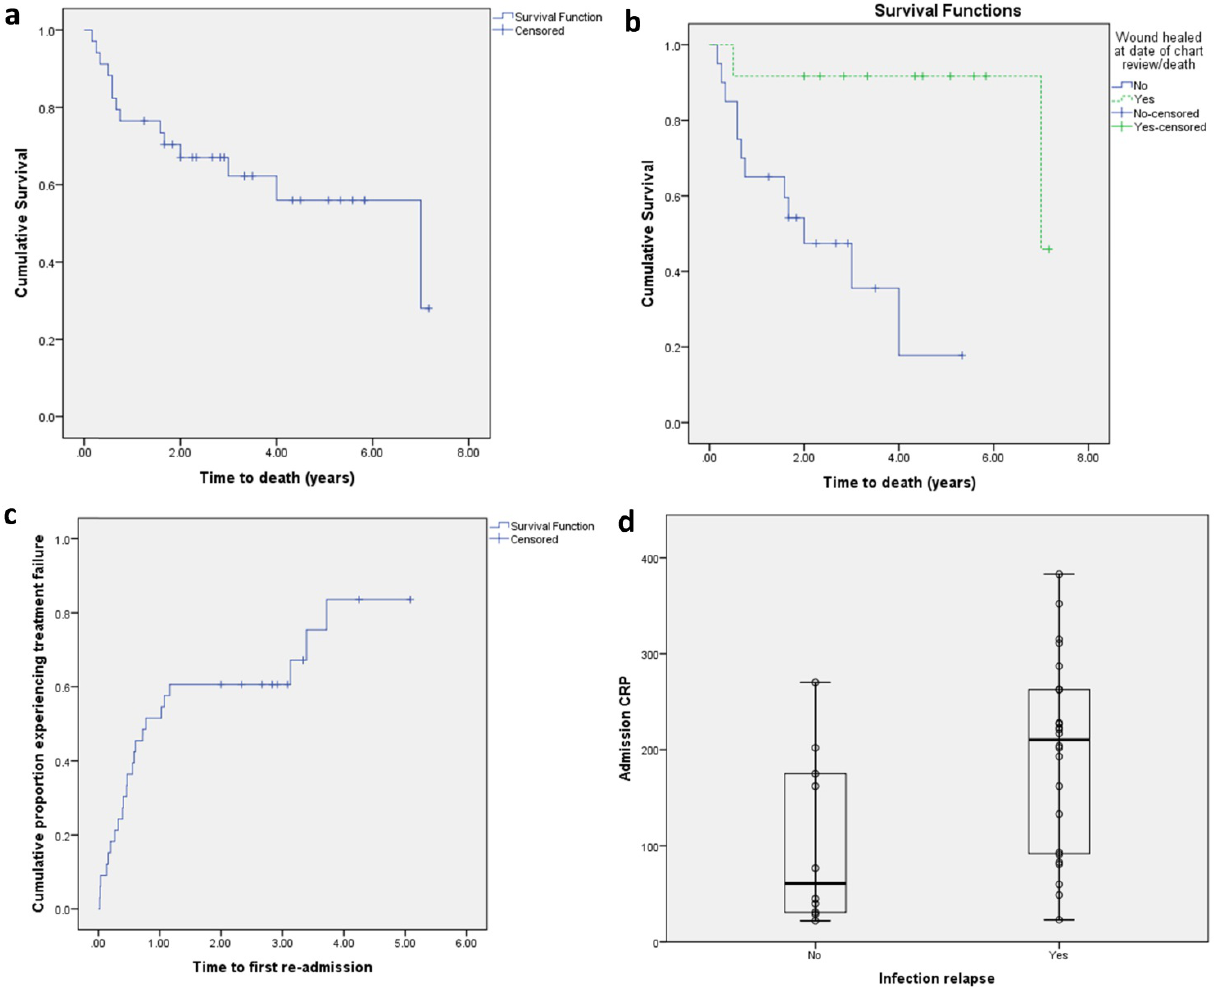
Figure 2. Clinical outcomes. a) Kaplan-Meier analysis of patient survival. b) Log rank analysis of patient survival between those with healed and non-healed pressure ulcers at time of final follow-up. c) Treatment failure. d) Admission C-reactive protein (mg L -1 ) at index presentation in the prediction of treatment failure.